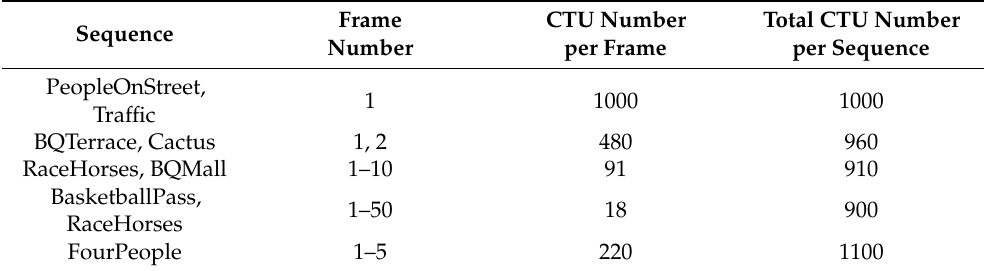
Table 2. Training